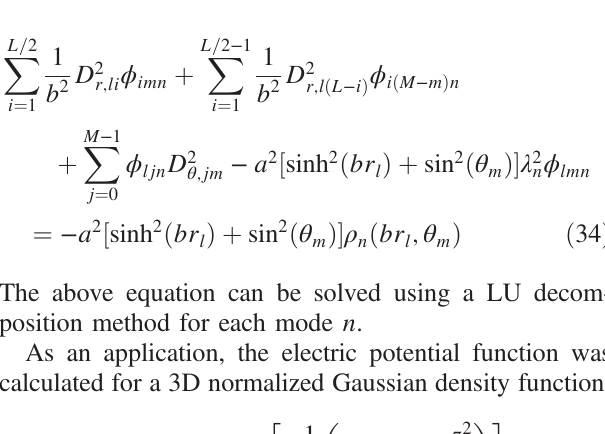
FIG. 5. The normalized electric potentials in the middle X − Y plane (upper left), the middle Z − Y plane (upper right) and the middle Z − X plane (bottom) from the pseudospectral method using a 3D bunched Gaussian density distribution with longitudinal periodic boundary condition and transverse elliptical conducting